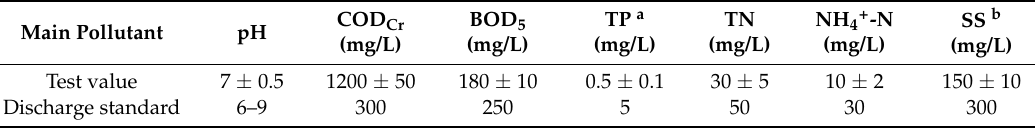
Figure 1. Flowchart of the painting wastewater treatment process with the new added multi ‐ level contact oxidation process (MLCOP) system. contact oxidation process (MLCOP) system. Table 1. Quality of wastewater used for Table 1. Quality of wastewater used for experiment.